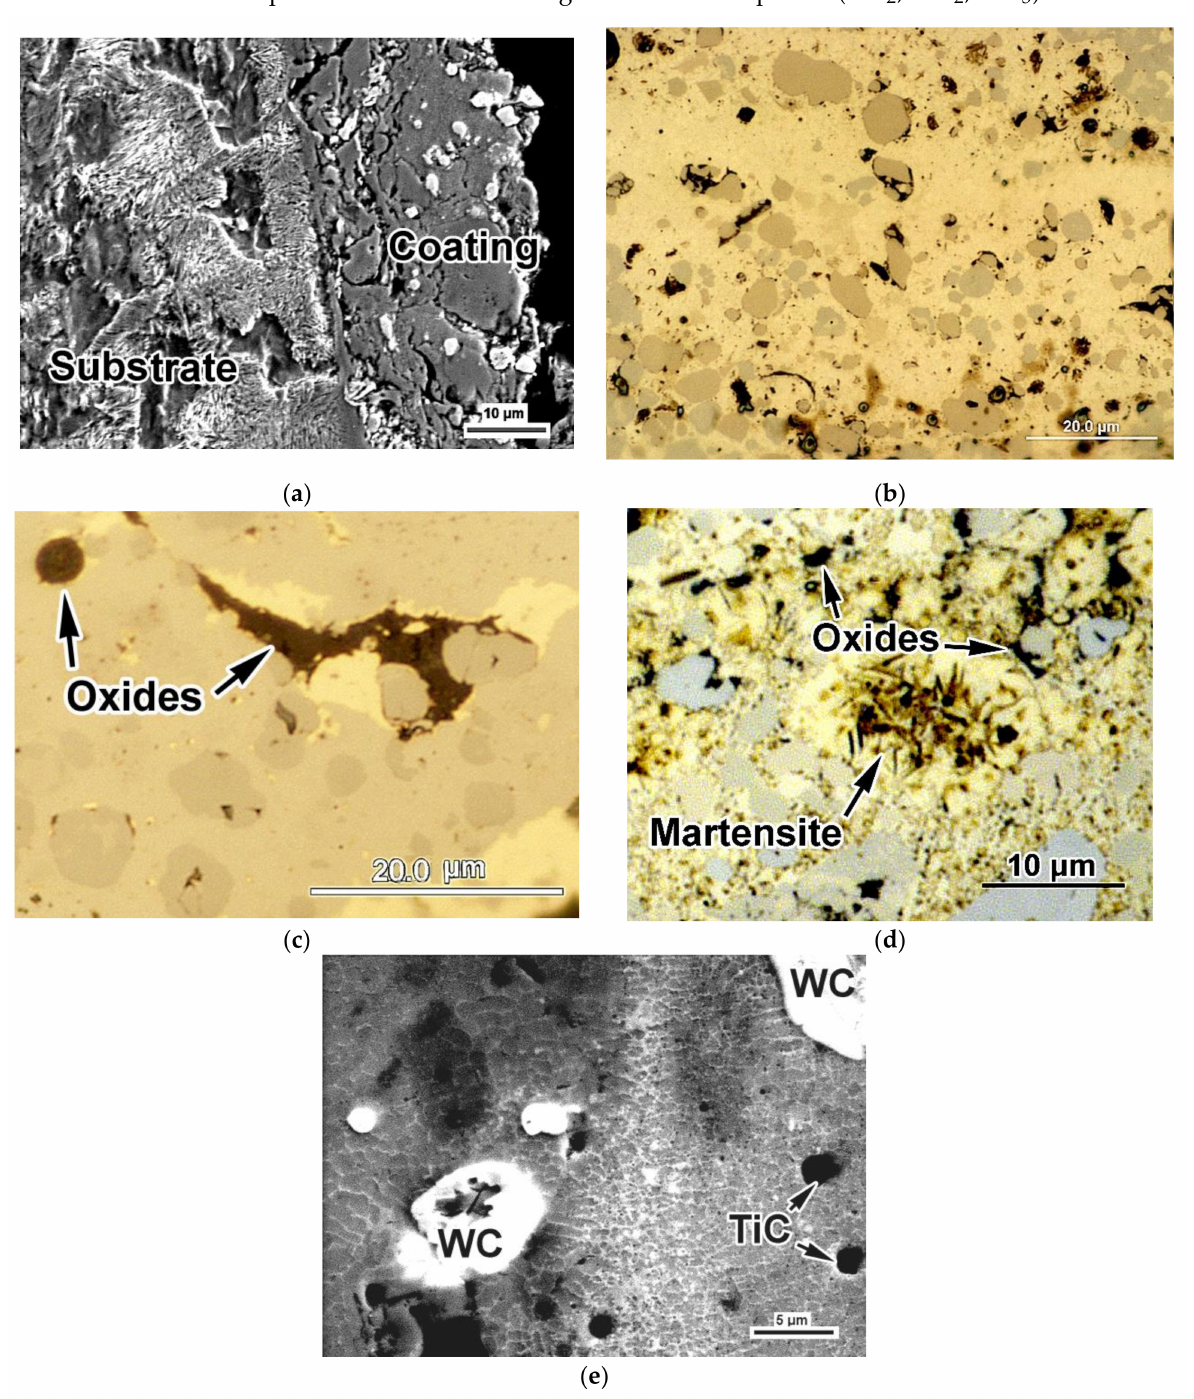
Figure 5. The coating microstructure: ( a , d ) cross-sectional direction, ( b , c ) a view from above. (( a )— SEM (secondary electron image—SEI); ( b – d )—OM, ( e )—SEM (back-scattered electron